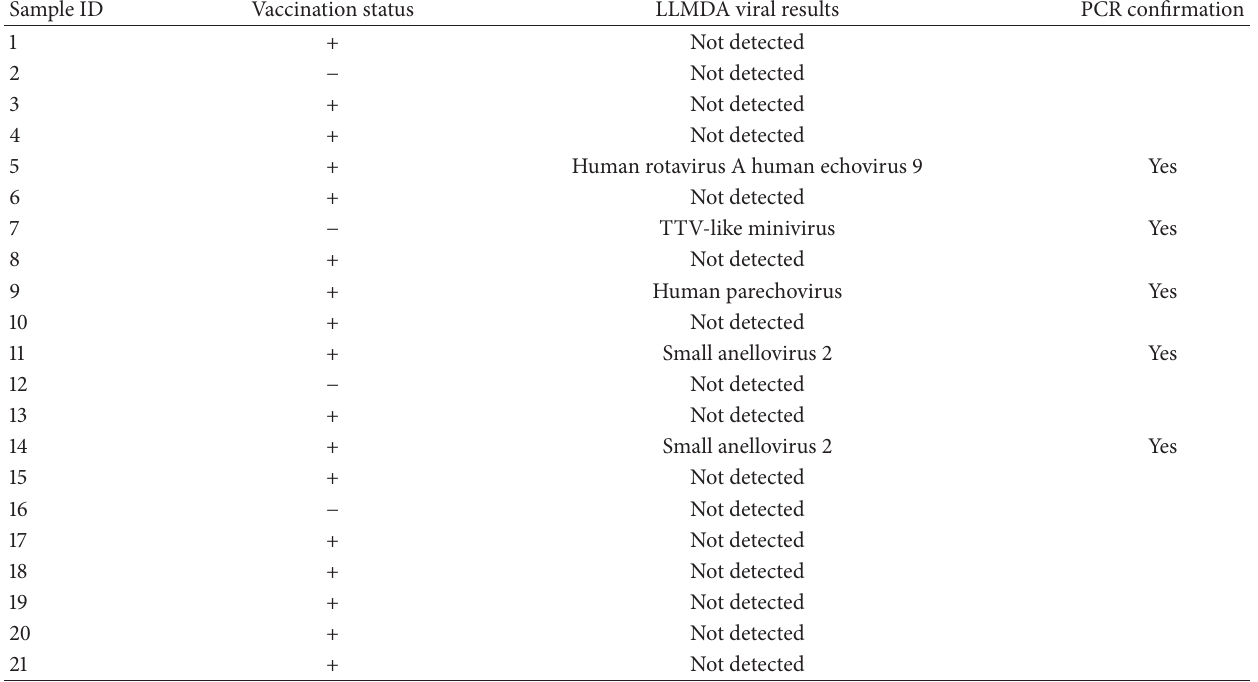
Table 3: Summary of vaccination status, viruses detected by microarray, and PCR confirmation results from human ileal samples. (+, vaccinated; − ,